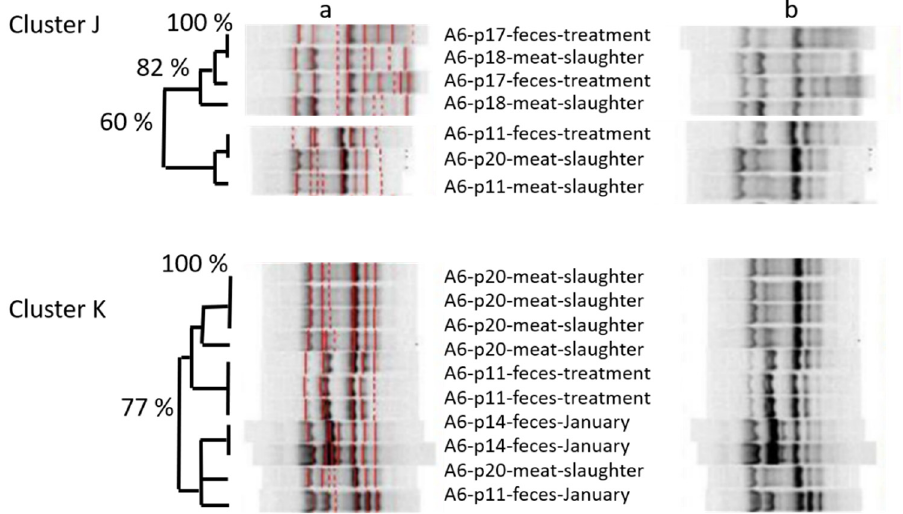
Figure 1. ERIC-amplicon-based cluster analysis of isolates from farm A6, taken at farm and at slaughter. Detail from the analysis of 2766 isolates in total, thereof 657 from farm A6. DNA-fragments were amplified by ERIC primers and visualized on 1% Agarose gel. All gels were aligned to standard bands: ( a ) software-based similarity assessment; ( b ) aligned, but unmarked bands for visual judgement. Numbers p11, p17, p18, p14, and p20: pigs tracked from November to January. All pigs slaughtered at the end of the tracking period. Cluster J, K: separate clusters with less than 50% similarity.